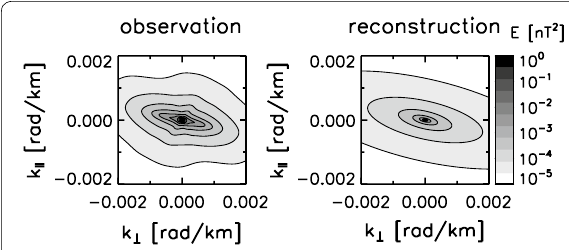
Fig. 10 Cluster observation of wavevector spectrum in the solar wind ( left panel ) and reconstruction using the spectral moments (eigenvalue ratio of 0.32 and eigenvectors of the spectral moment tensor) and the elliptic power-law model ( right panel ). The flow direc- tion is normal to the